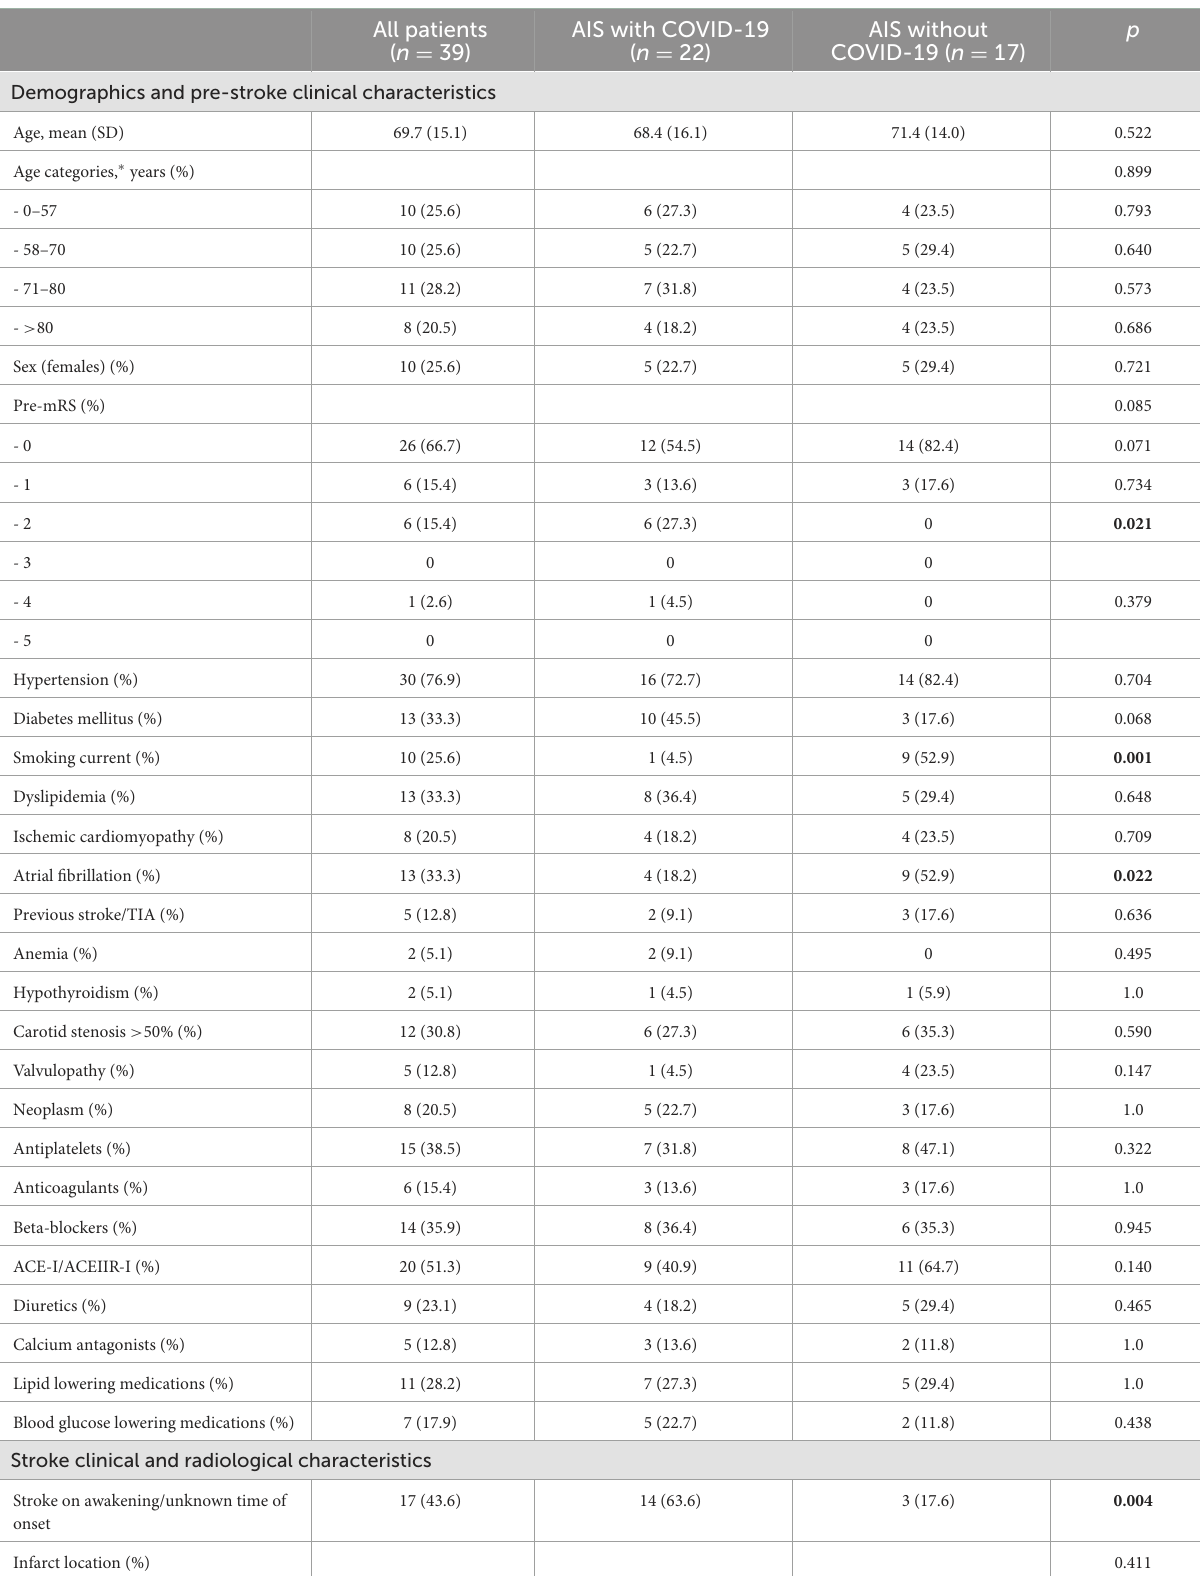
TABLE 1 Demographics and clinical characteristics of the overall study AIS patient population and by COVID-19 diagnosis.